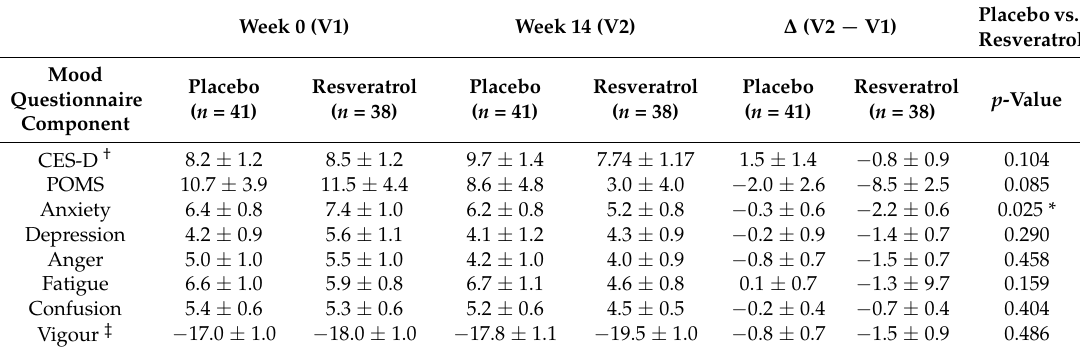
Table 4. Participants’ mood profiles and individual measures. Data are presented in mean ± SEM.